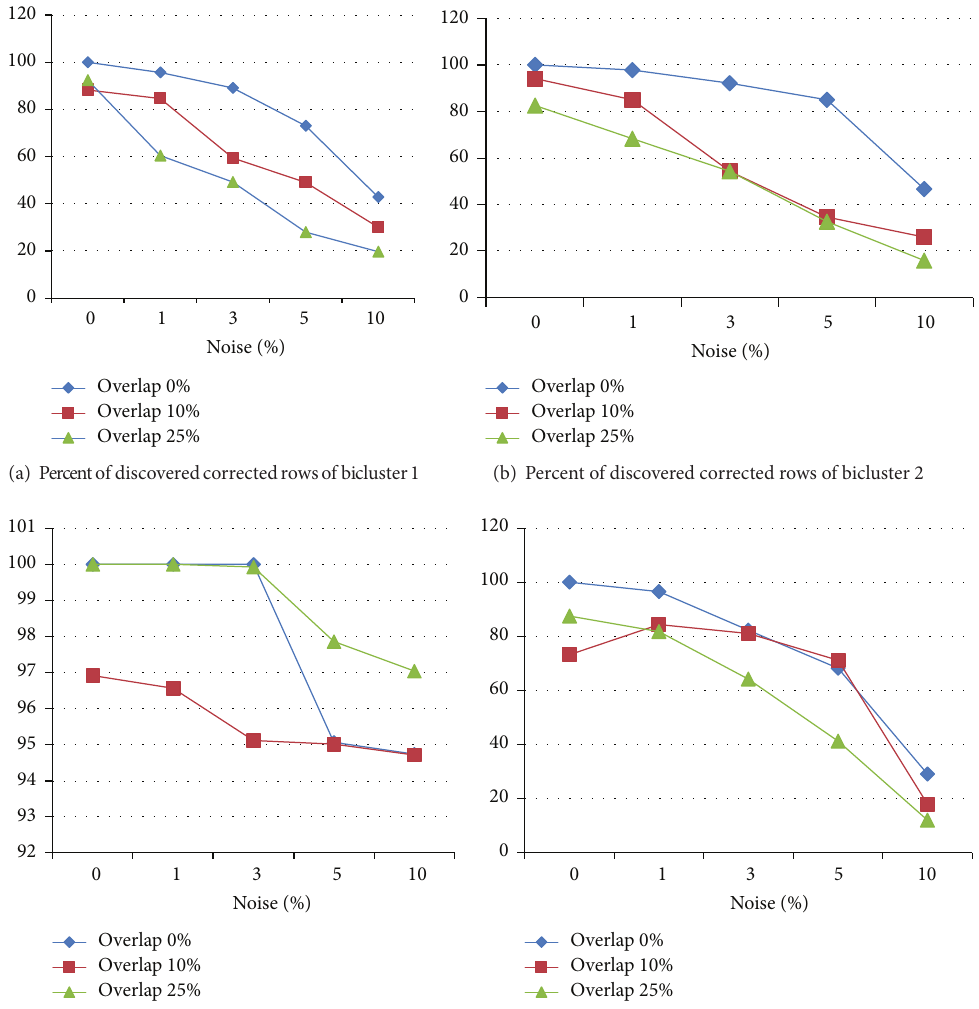
Figure 1: Corrected rows and columns of discovered biclusters in matrix with dim 500 ×